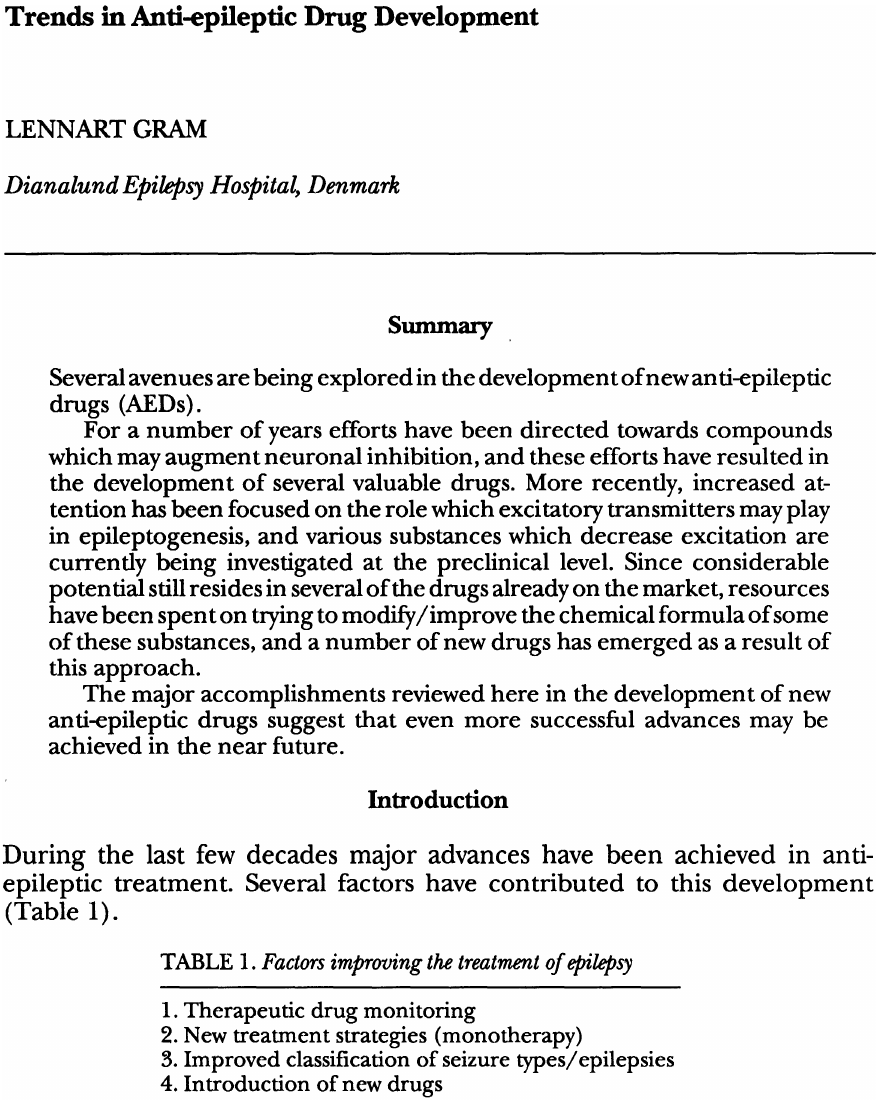
TABLE 1. Factors improving the treatment of epilepsy 1. Therapeutic drug monitoring 2. New treatment strategies